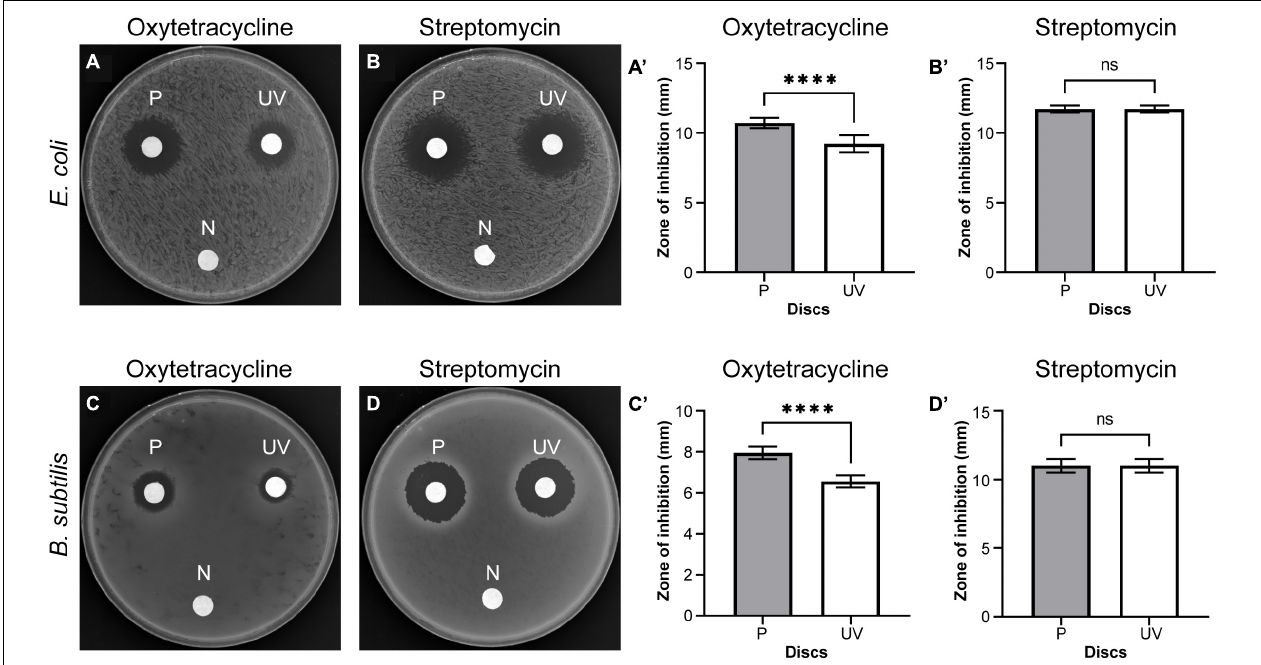
FIGURE 2 | UV irradiation significantly decreases the efficacy of oxytetracycline. Representative results of the disc-diffusion assay for UV-treated oxytetracycline (A,C) or streptomycin (B,D) conducted using B. subtilis and E. coli are shown. Quantification of the zones of inhibition in millimeters are plotted for oxytetracycline (A’,C’) and streptomycin (B’,D’). Significance was determined using a one-way ANOVA with Tukey’s multiple comparisons analysis. Error bars represent standard deviation (SD) of the mean from three biological replicates. N: negative control (discs prepared with sterile water), P: positive control (discs prepared the day of testing), UV: UV-treated discs. ∗∗∗∗ p < 0.0001, ns, not